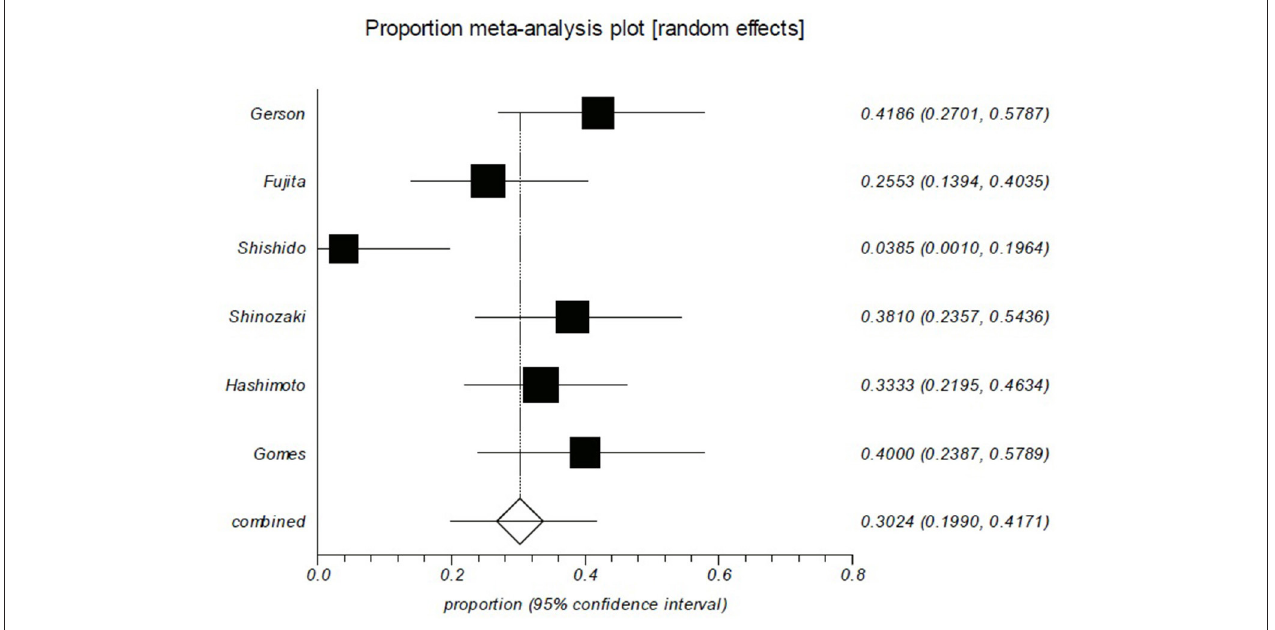
FIGURE 4 | Rebleeding rate of patients in the long follow-up group is ∼ 30%. Forest plot shows that 30.2% (95% CI: 19.9–41.7%) of the patients who had been followed up more than 2 years experienced rebleeding. There was evidence of heterogeneity among the studies ( p = 0.0018